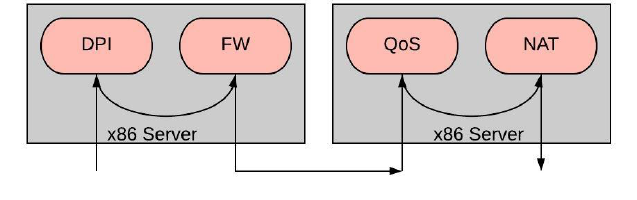
Figure 3. Single-Feature Deployment.